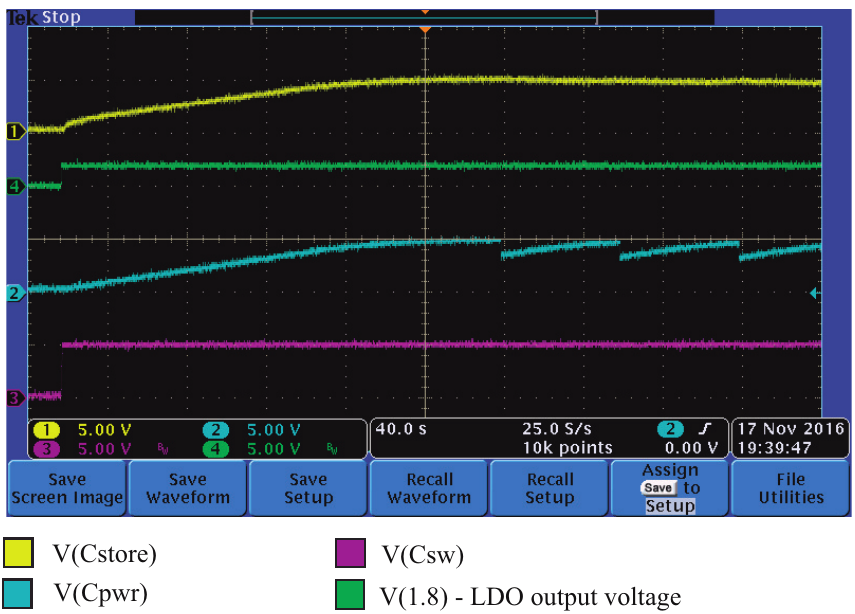
Figure 13. Power-up sequence in the energy harvesting